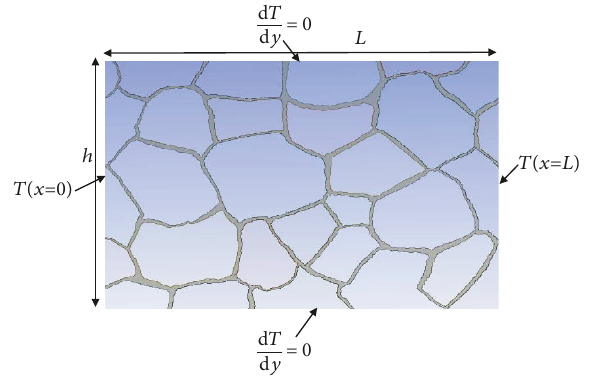
Figure 2: Boundary conditions for the numerical